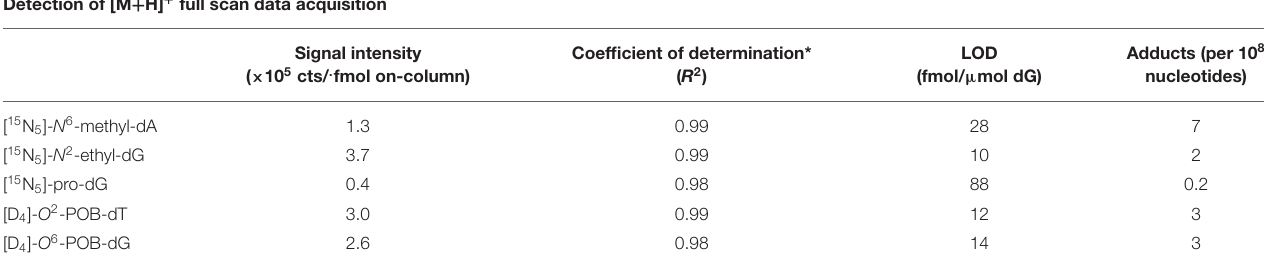
TABLE 3 | Assessment of instrumental sensitivity, linearity, and detection limits. Detection of [M + H] + full scan data acquisition Signal intensity ( × 10 5 cts/ . fmol on-column)